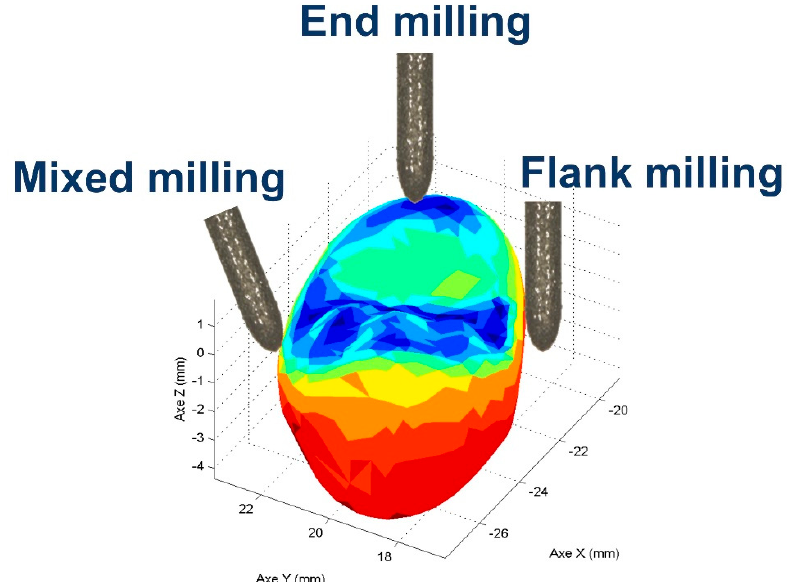
Figure 8. Tool milling mode applied on a dental crown, where the areas milled in end milling mode are in blue (occlusal shape)